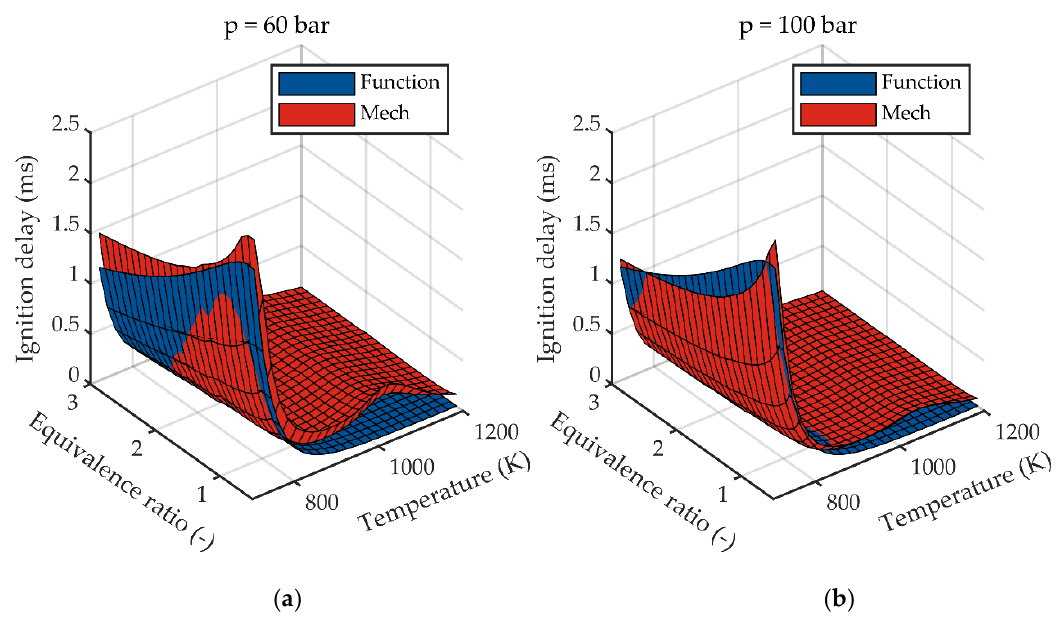
Figure 2. Ignition delay over temperature and equivalence ratio predicted by the reaction mechanism and the ignition function for an ambient pressure of 60 bar ( a ) and 100 bar ( b ).